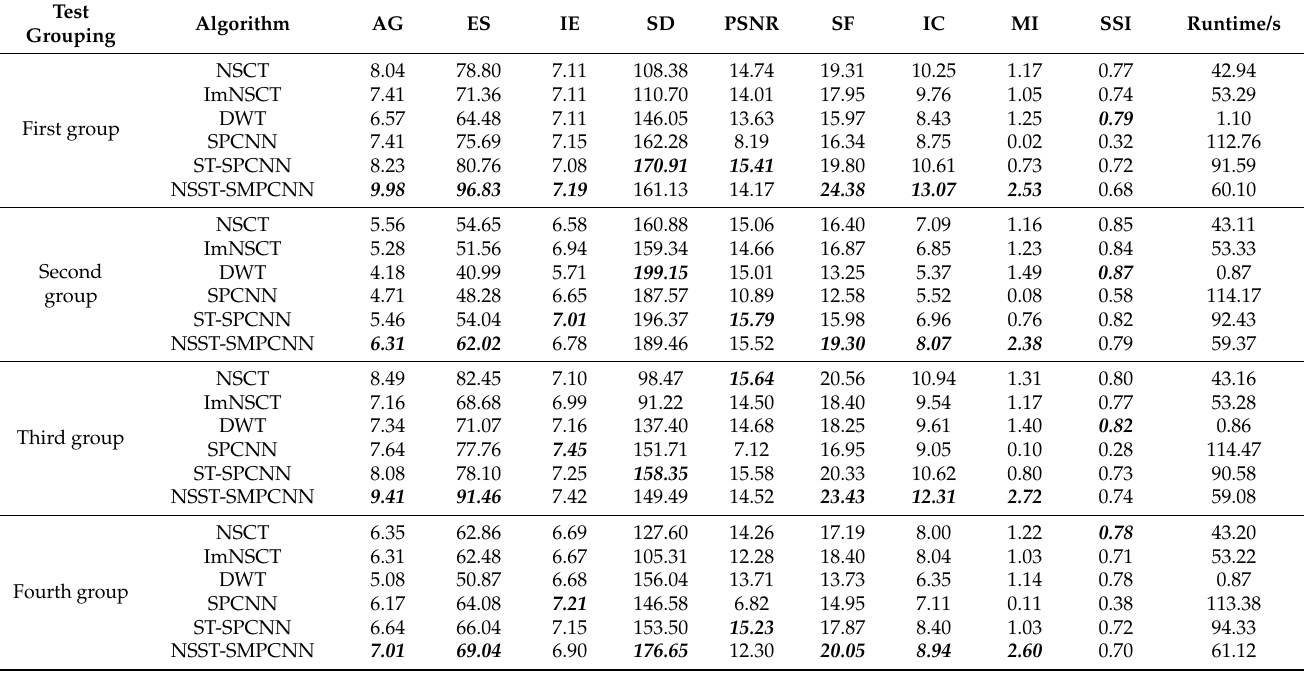
Table 1. Objective evaluation index results of dataset